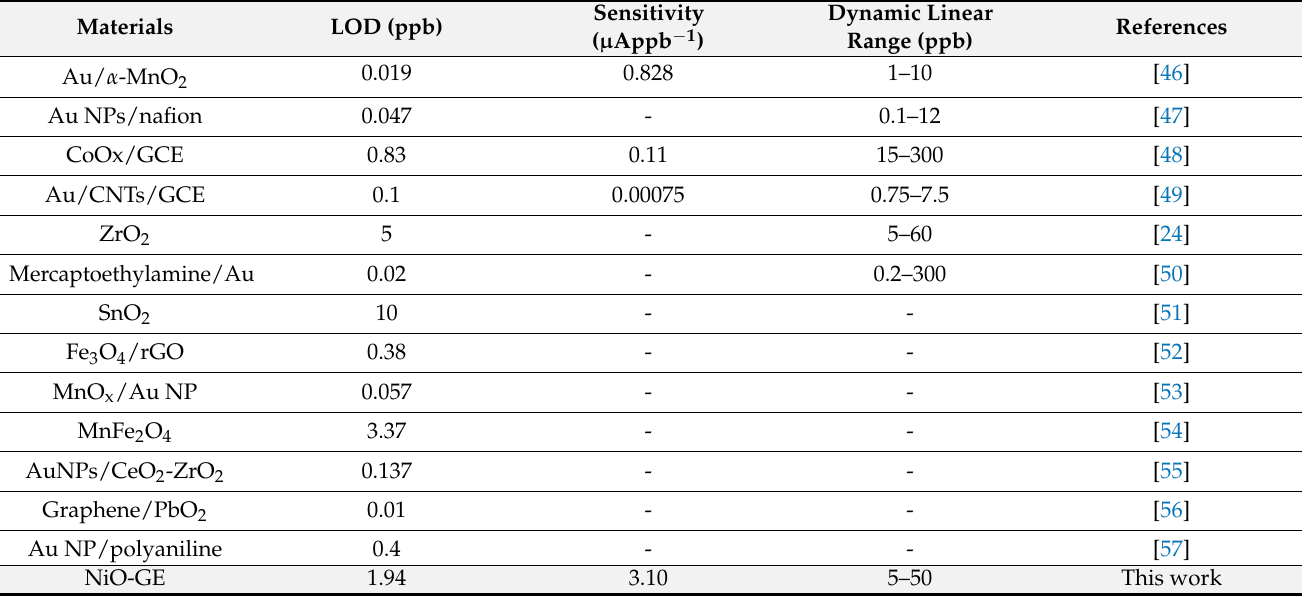
Table 1. Comparison of performance of NiO-GE with previous